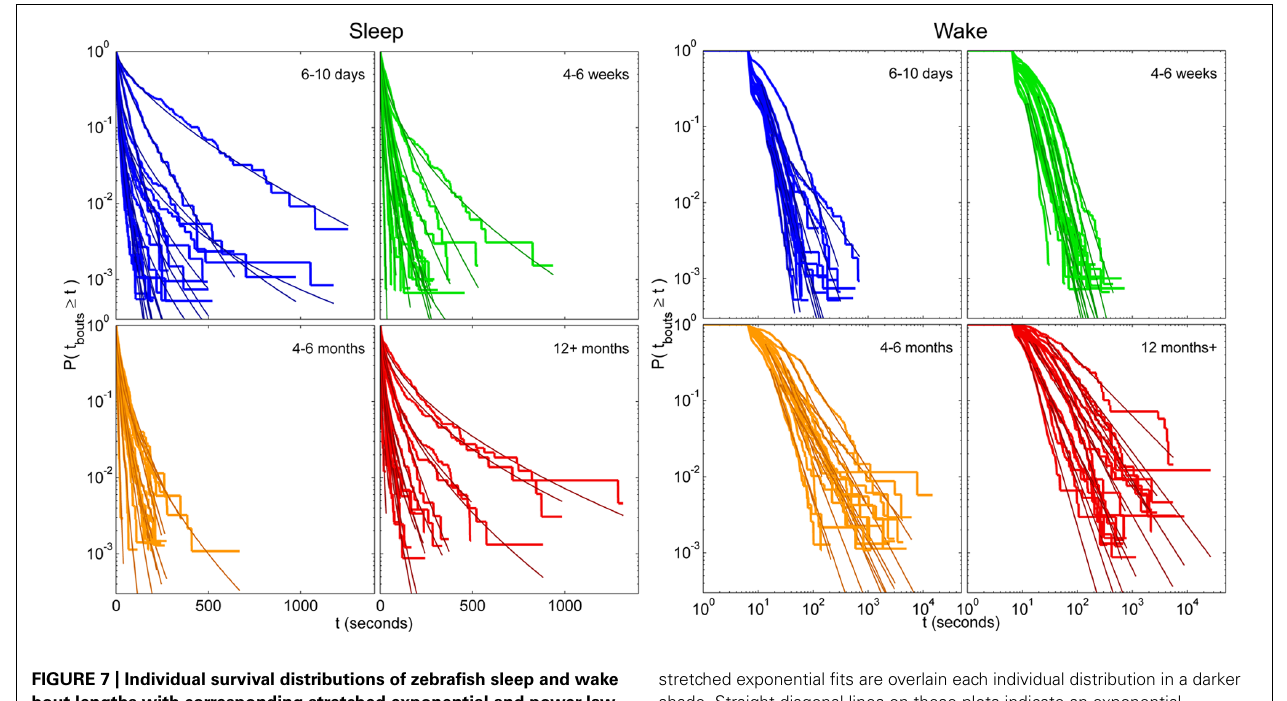
stretched exponential fits are overlain each individual distribution in a darker shade. Straight diagonal lines on these plots indicate an exponential distribution of bout lengths. On the right the axes are shown in log–log coordinates and power-law fits are overlain each individual distribution in a darker shade. Straight diagonal lines on these plots indicate a power-law